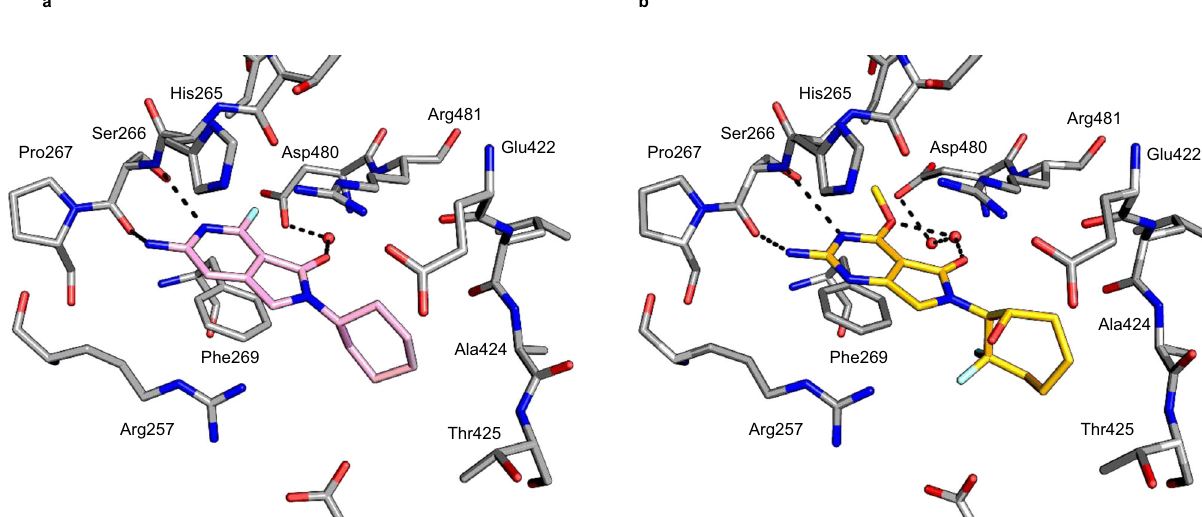
Fig. 2 | Compounds bound in the LysRS catalytic binding site. a 2 is shown in pink carbon atoms, and surrounding protein residues are shown with gray carbon atoms.Oxygenatomsareshowninred,nitrogenatomsindarkblue,and fl uorinein